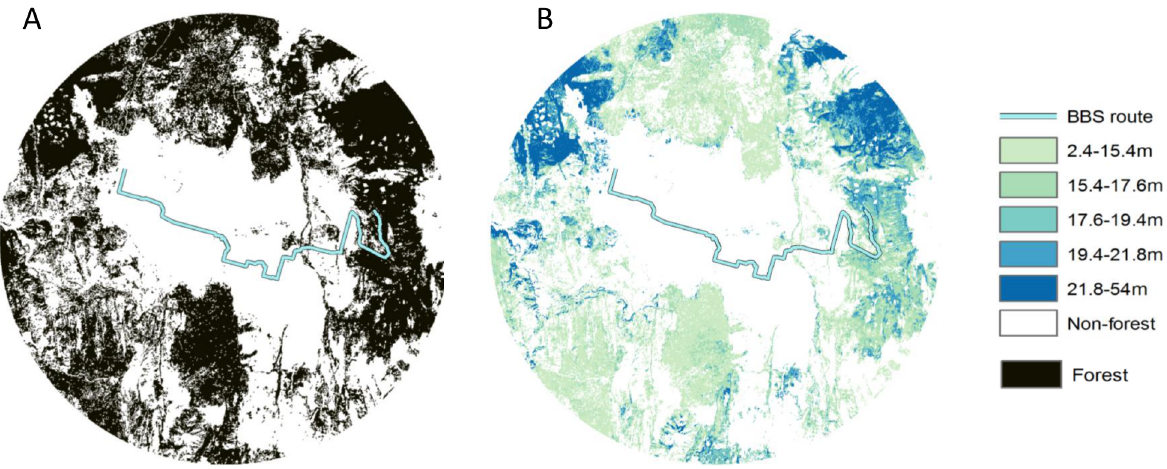
Figure 1. An example of the delineation of habitat patches at one BBS location. A two-dimensional vegetation map (A) and a vegetation map segmented by height structure (B) are shown. The pixel-based segmentation method (supporting information S1) is used to segment two dimensional habitat maps by using height thresholds.